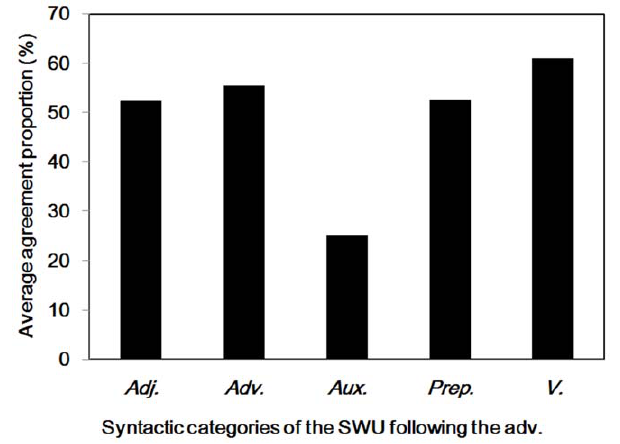
Figure 5. Adverbs and the subsequent words. Average agree- ment proportions for word boundaries between the adverbs and different subsequent syntactic categories of SWU. Adj.=adjectives; Adv.=adverbs; Aux.=auxiliary words; Prep.=prepositions; V.=verbs.